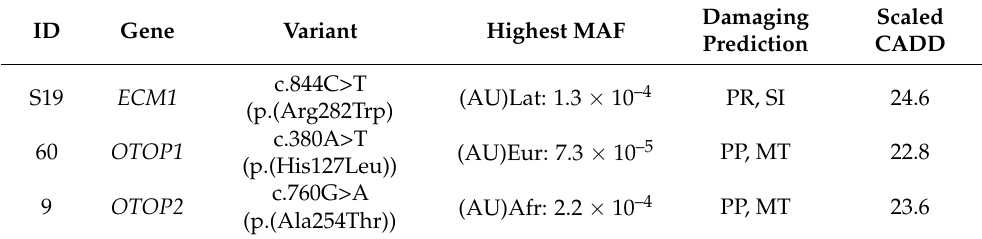
Table 4. Rare variants in Spanish probands with Meniere’s